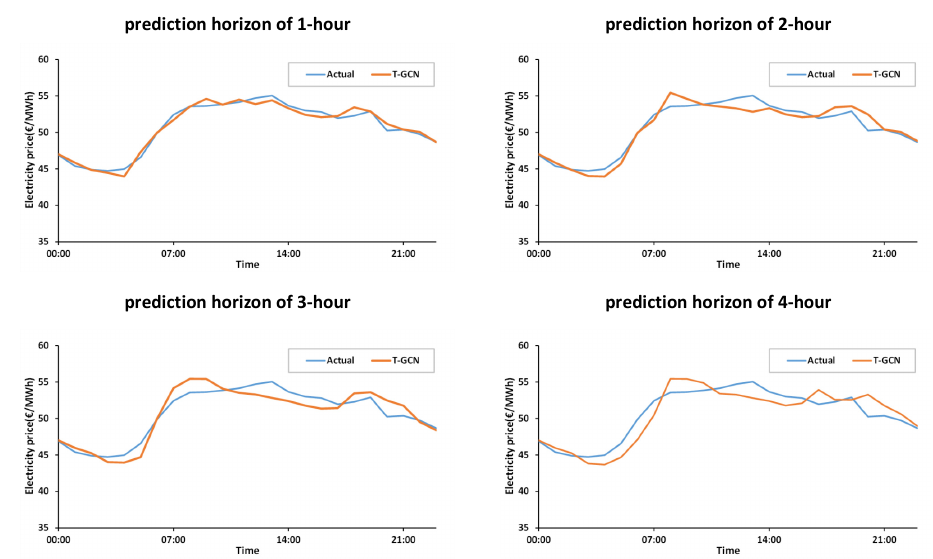
Figure 10. The visualization results for different prediction horizons.